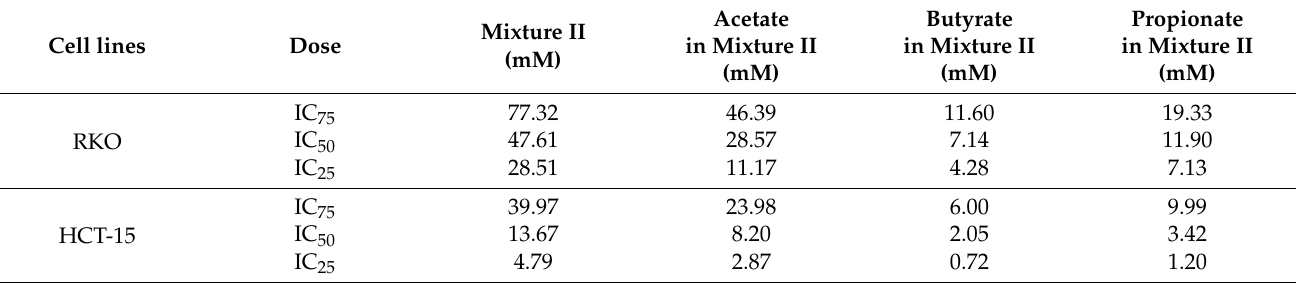
Figure 2. Predicted and observed effects of the SCFAs mixtures. (I-II) Predicted and observed effects of the SCFAs mixtures I ( A) and II ( B ) of the three tested SCFAs in RKO ( Aa , Ba ), HCT-15 ( Ab , Bb ) and NCM460 ( Ac , Bc ) cells by SRB assay. Individual data points are represented by black circles, and the best-fit regression model is shown by the black line, labeled “observed effect”. Black dashed lines represent the upper and lower 95% CI for the regression fit. The solid red line shows the prediction according to concentration addition (CA). The blue dotted lines show the IC 50 for each response curve (for values see Table 2). Experimental data were obtained from a minimum of three independent experiments run in triplicate. Table 3. Concentrations of SCFAs used for the comparison between the individual and combined